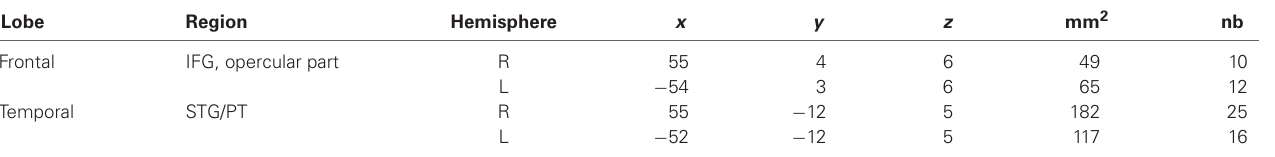
Table 2 | Frontal and temporal generators of the change-specific response within S2 . Lobe Region